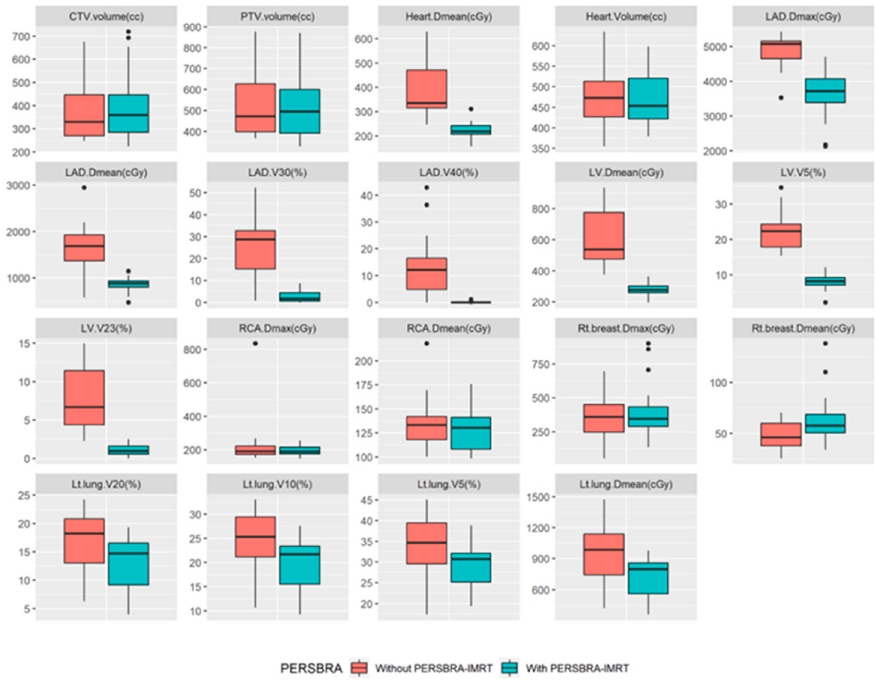
Figure 5. Box plots of target and organs at risk without PERSBRA versus with PERSBRA. Abbreviations: CTV = clinical target volume, PTV = planning target volume, LV = left ventricle, LAD = left anterior descending artery, RCA = right coronary artery.